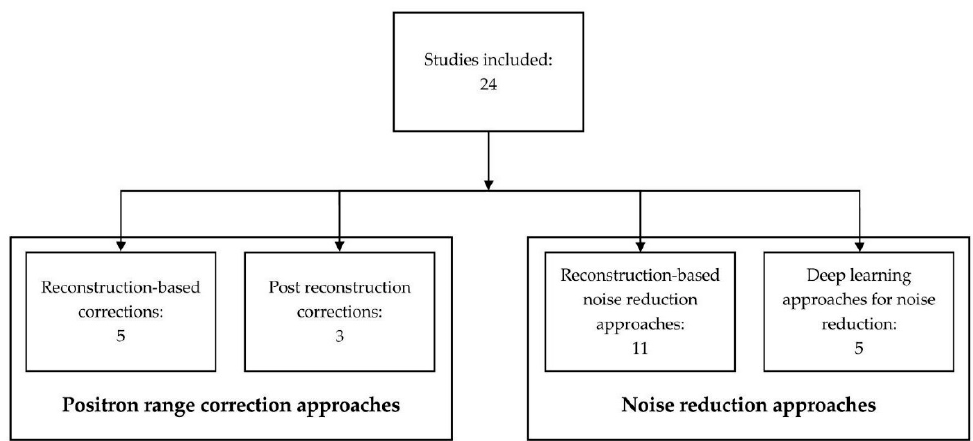
Figure 2. Categorization of the literature search with the numbers depicting the number of articles per category.